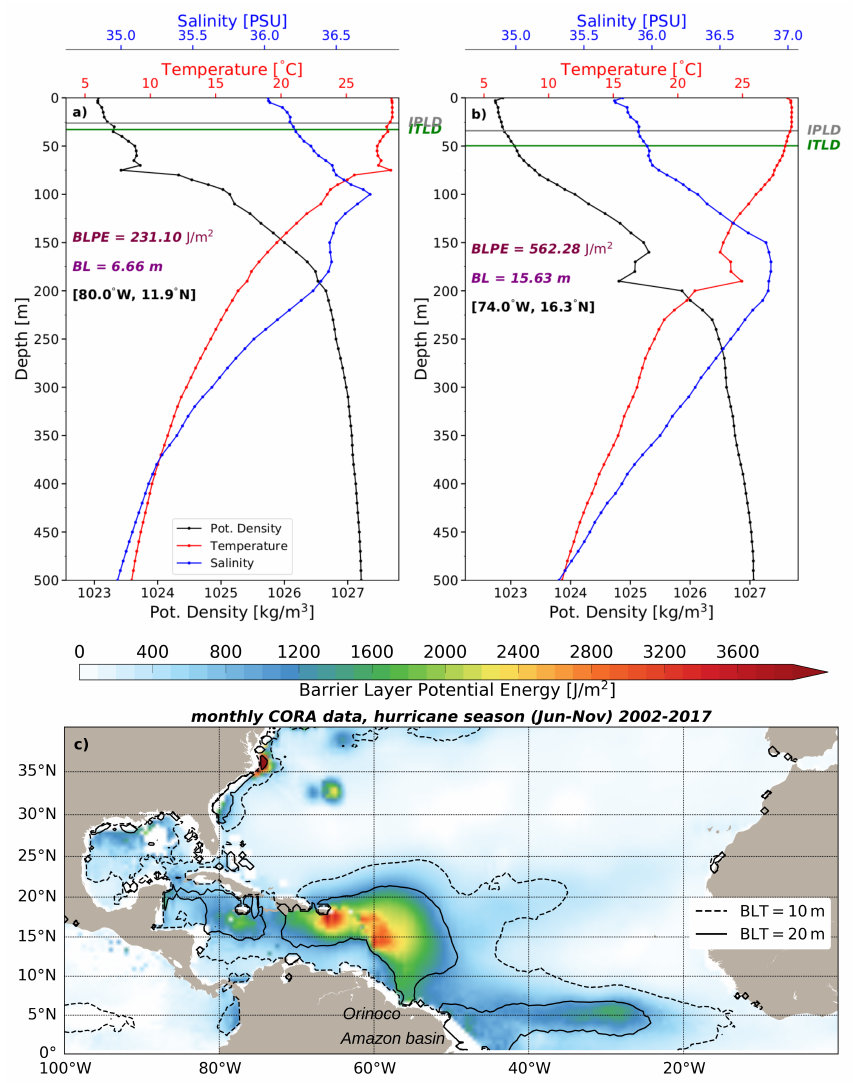
Figure 4. ( a , b ) Example of potential density (black line), temperature (red line) and salinity (blue line) derived from the CORA dataset for two grid points in the Caribbean Sea (exact location in bold numbers). The potential density has been computed with the UNESCO formula described in Fofonoff and Millard [46]. ITLD and IPLD refer to the isothermal and isopycnic layer depths, which are used to compute the barrier layer thickness (BLT) and the Barrier Layer Potential Energy (BLPE) according to Equations (1) and (2) respectively. ( c ) Mean BLPE (shading) and BLT (black contours) for the hurricane season (June to November) in the North Atlantic from 2002 to